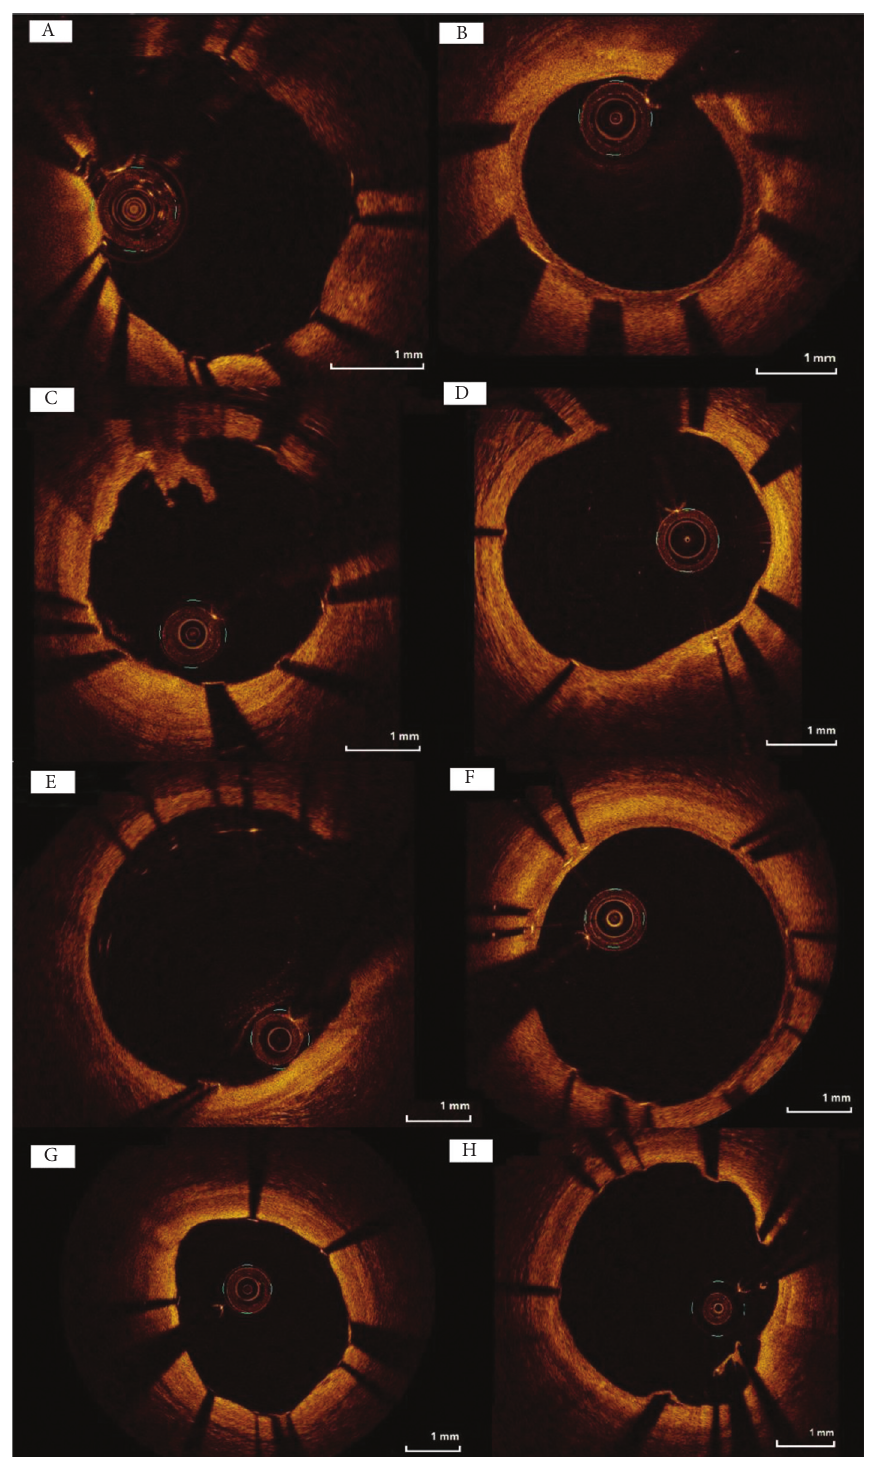
Figure 2: Examples of optical coherence tomography (OCT) cross sections obtained from our study’s population: (a) OCT at index percutaneous coronary intervention (PCI); (b) OCT at follow-up. (A) Optimal stent apposition; (B) normal healing; (C) optimal stent apposition with plaque prolapse; (D) normal healing; (E) stent malapposition with incomplete stent apposition area; (F) resolved mal- apposition; (G) optimal stent apposition; (H) acquired stent malapposition with incomplete stent apposition